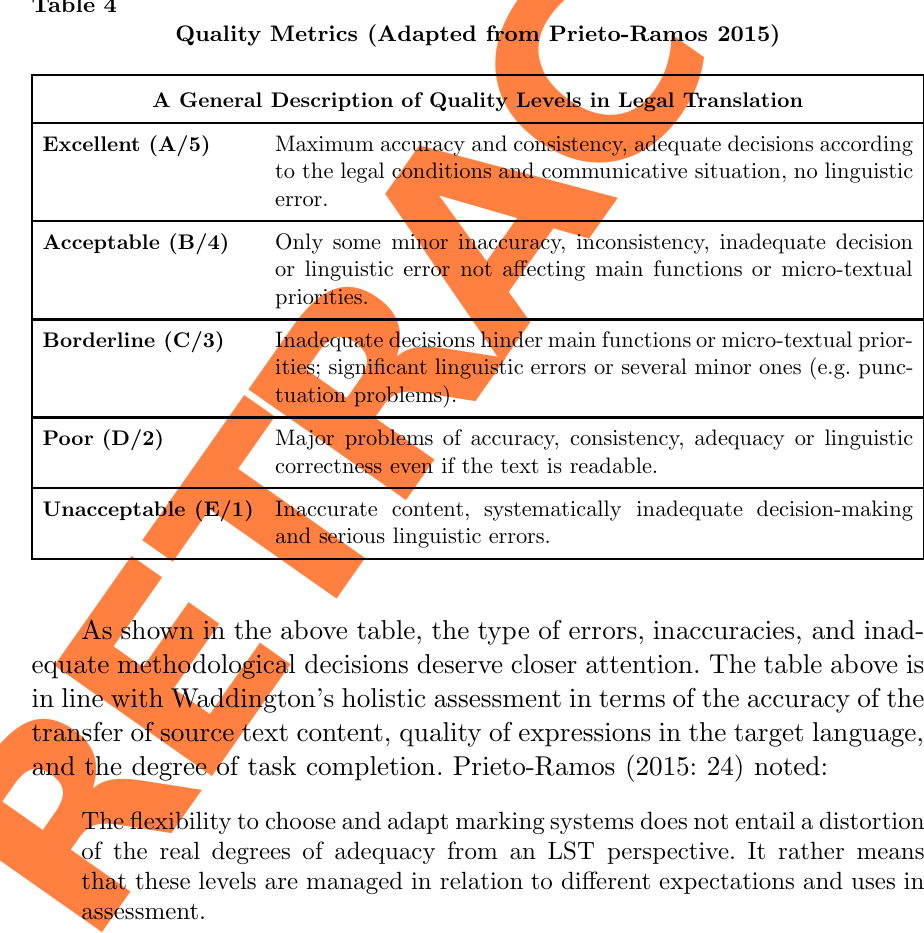
Quality Metrics (Adapted from Prieto-Ramos